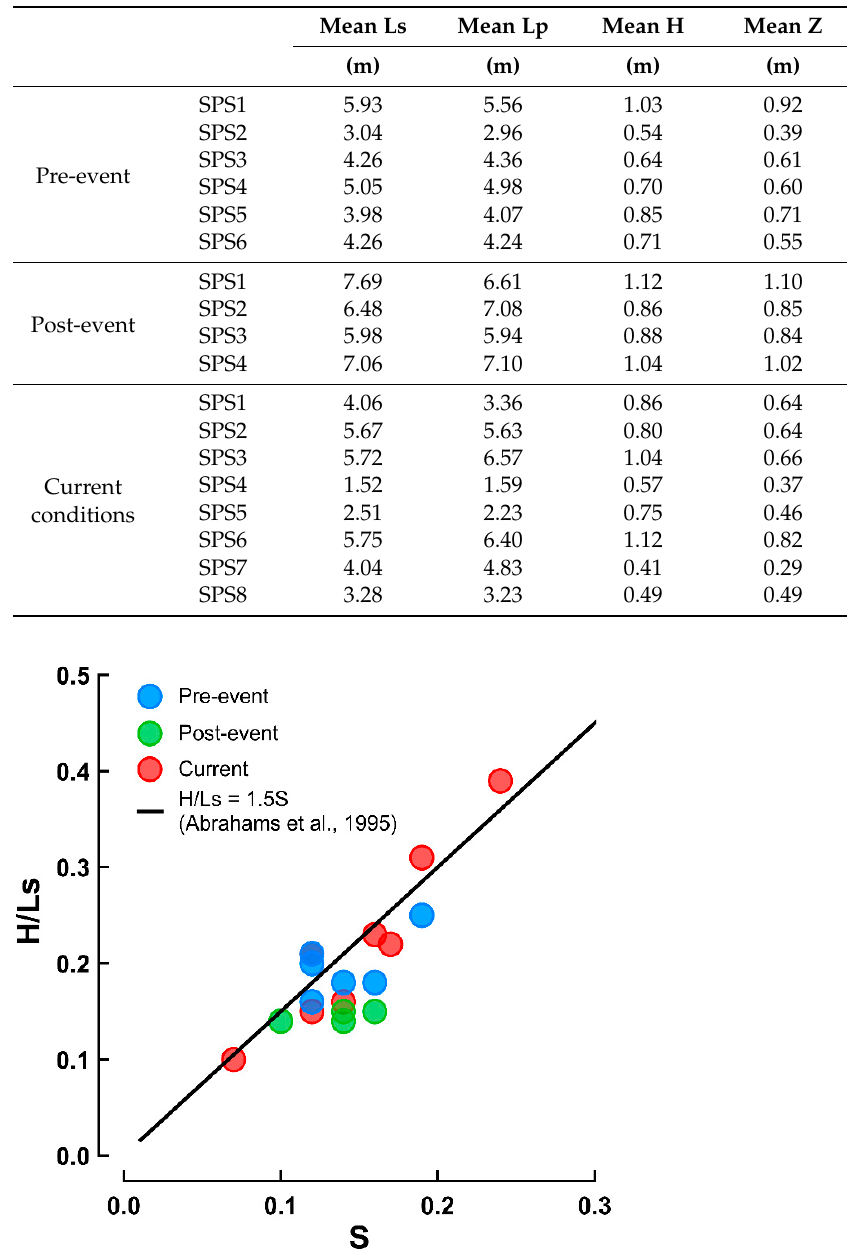
Figure 7. Relationship between S and mean steepness (H/Ls) for each step–pool sequence observed pre-event, post-event, and in the current conditions. Black line is the function H/Ls = 1.5 S, which describes the maximized flow resistance.